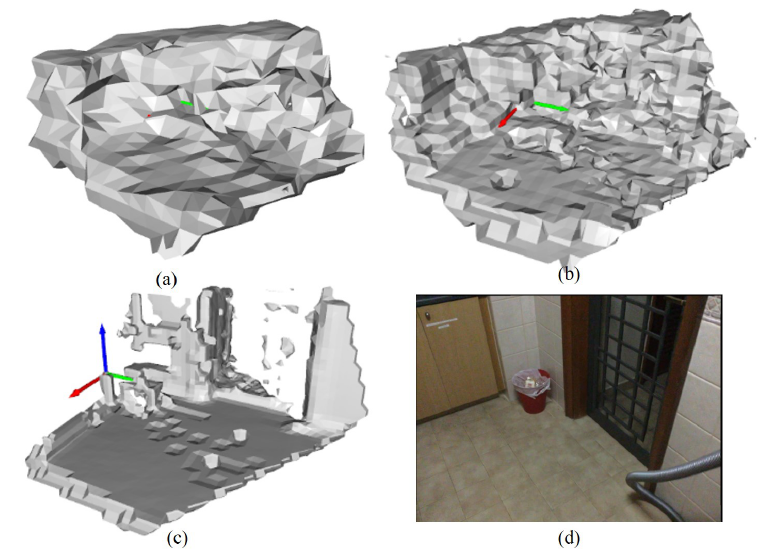
Figure 9. Partial dense TSDF maps and corresponding image. Estimated maps with voxel sizes of 16 cm and 8 cm are shown in ( a , b ) respectively. The ground-truth map with a voxel size of 4 cm is shown in ( c ). The RGB image from the corresponding key frame is in ( d